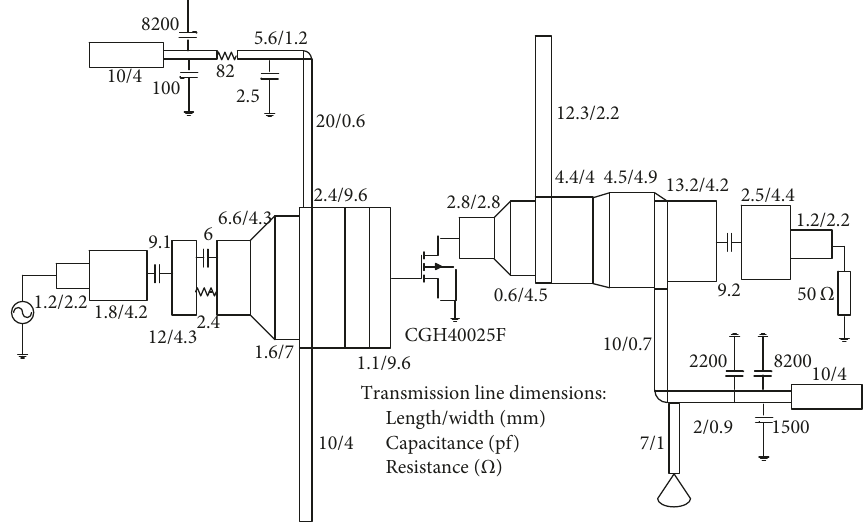
Figure 7: Schematic of the complete power amplifier.